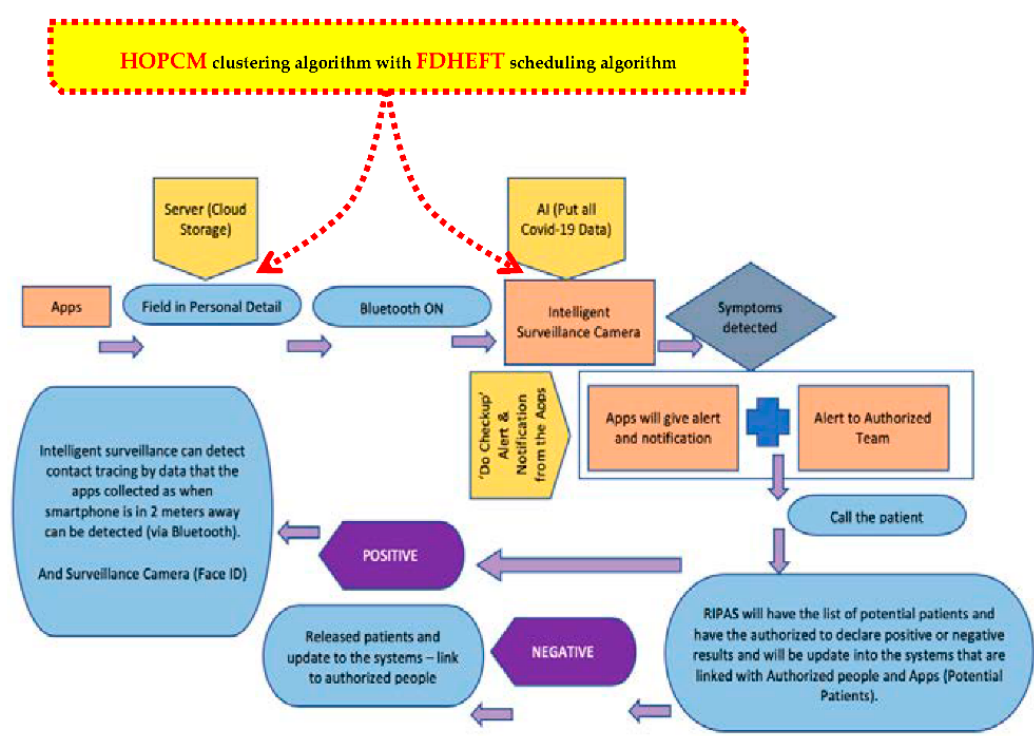
Figure 7. Processes flow of cloud-based smart health.